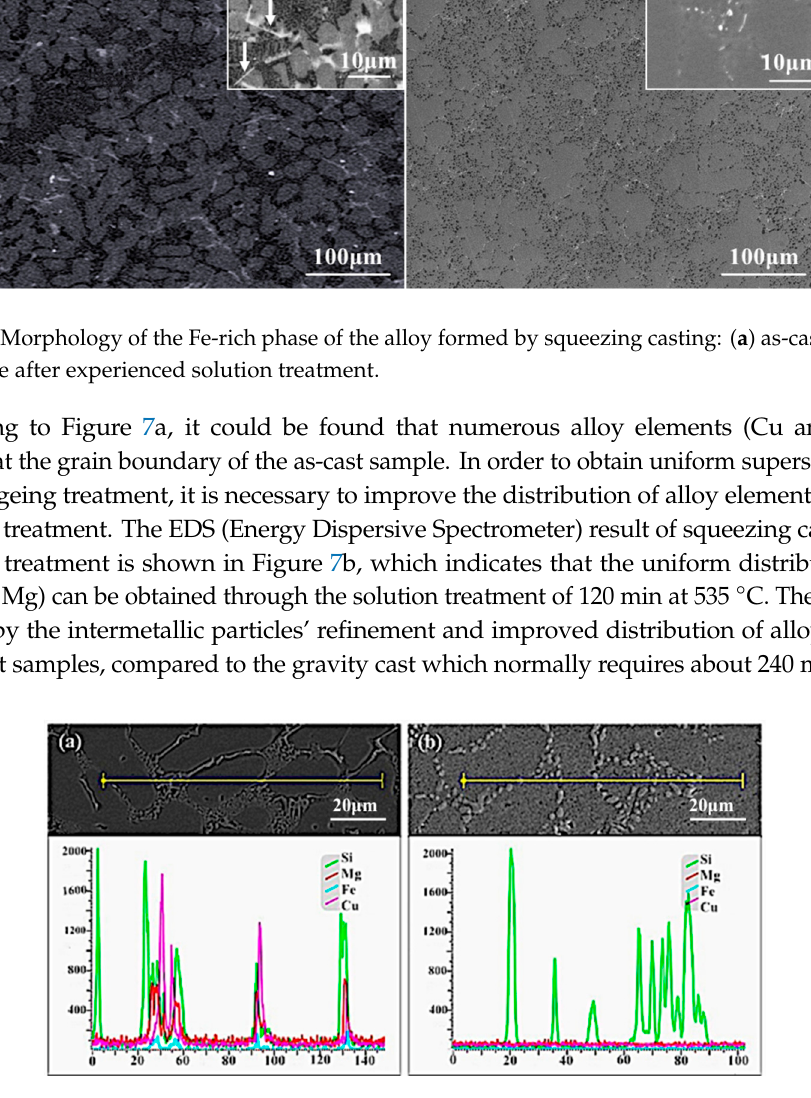
Figure 7. EDS (Energy Dispersive Spectrometer) results of alloy formed by squeezing casting technology ( a ) EDS result of the as-cast alloy; ( b ) EDS result of the alloy after solid solution treatment.